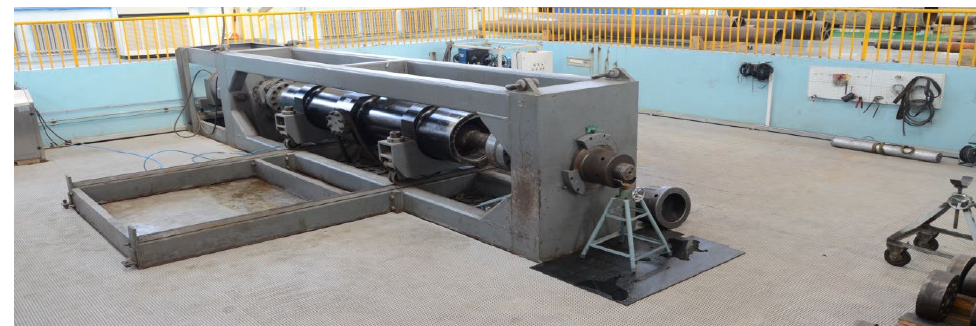
Figure 4. External pressure collapse test system.